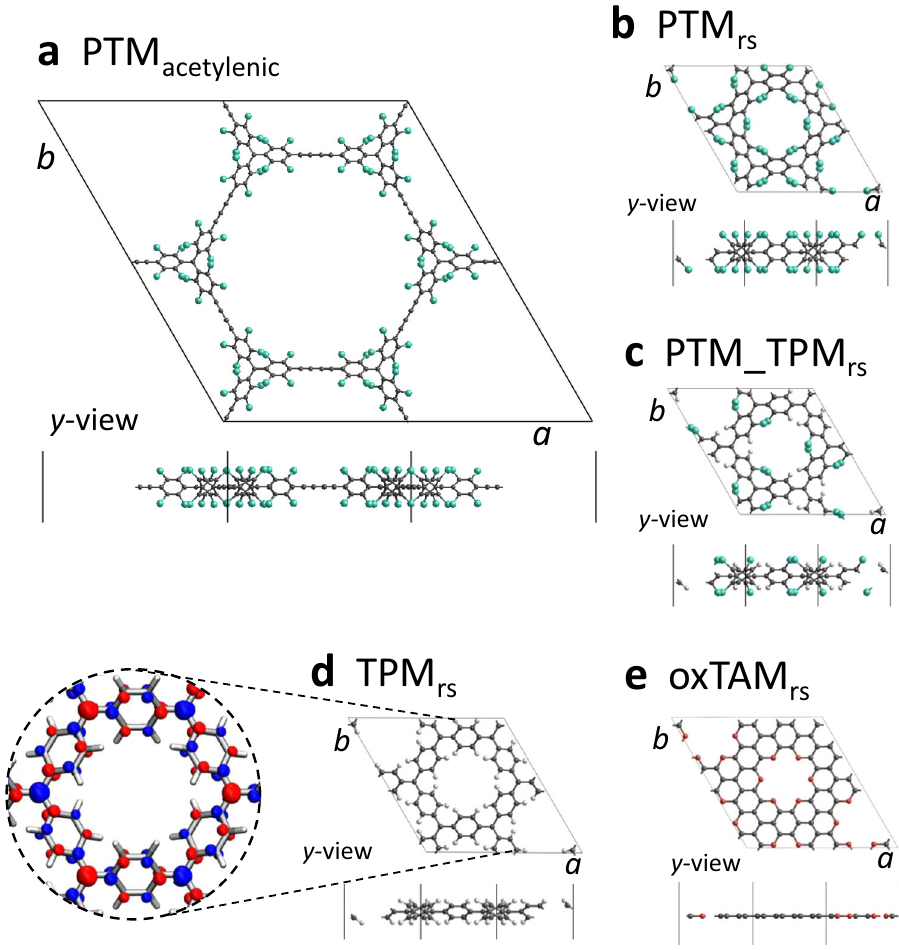
Fig. 2 2D-CORF characterisation. DFT-optimised crystal structures of a PTM acetylenic , b PTM rs , c PTM_TPM rs , d TPM rs and e oxTAM rs 2D-CORFs. Colouring: C — dark grey, H — white, Cl — green, O — red. The spatially resolved spin density for the AFM solution (spin-up: blue, spin-down: red) is shown for TPM rs ( d